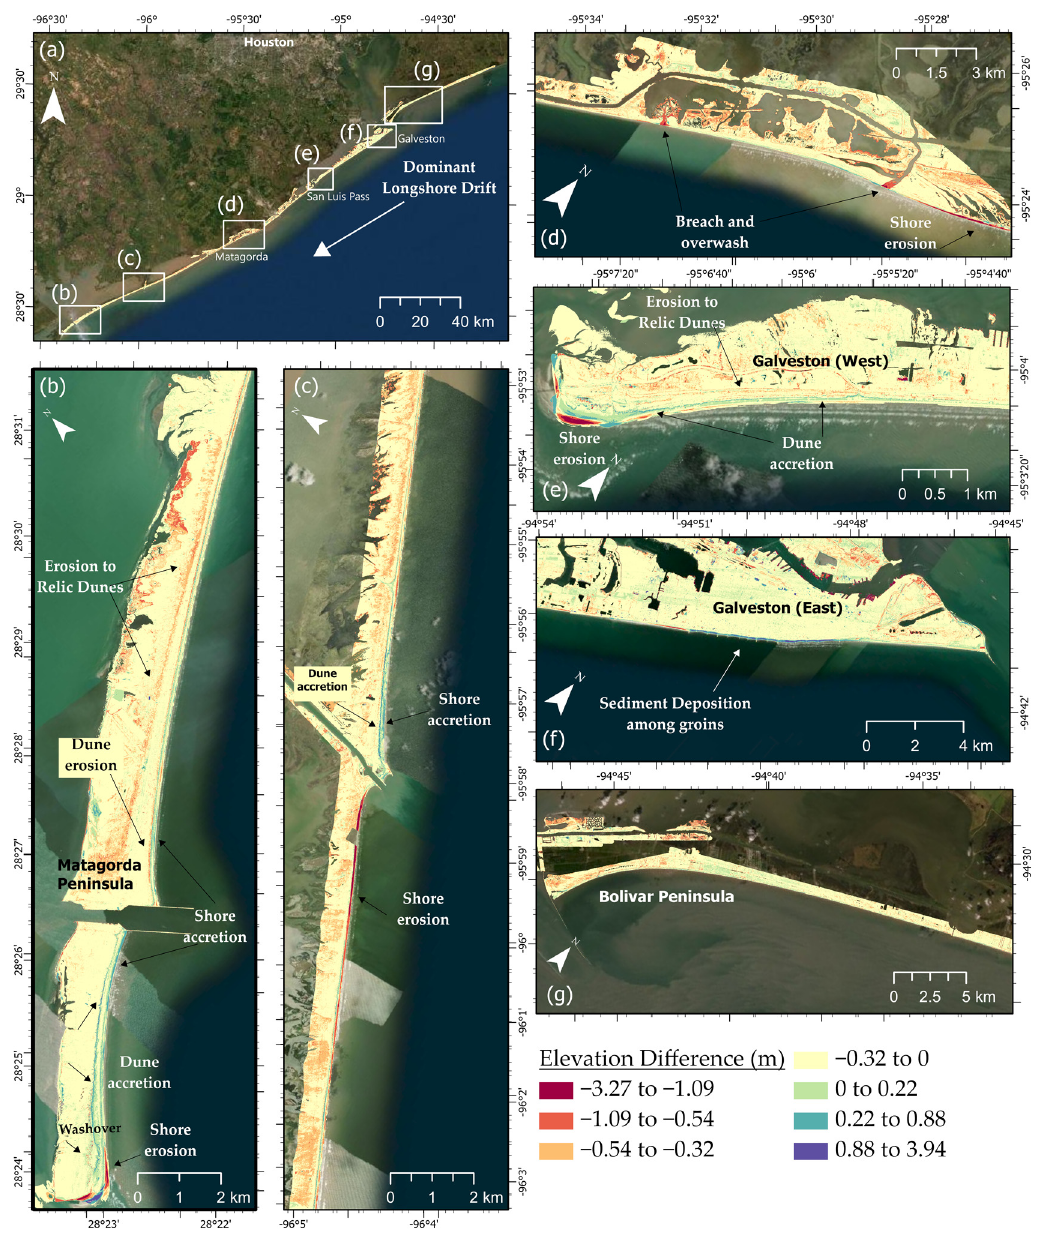
Figure 7. Digital elevation model difference map representing changes between 2016 and 2018. Erosion is represented by yellow, orange, and red. Sediment accretion is represented by green, turquoise, and purple. ( a ) For the full extent of regional data, refer to Figure 1b for the regional study extent in reference to the state of Texas; ( b ) Western end of Matagorda Peninsula; ( c ) Changes around Jetty Park and Matagorda Beach; ( d ) Overwash fans between Sargent and Freeport; ( e ) West end of Galveston Island; ( f ) East end of Galveston Island with seawall, jetty, and groins; ( g ) Bolivar Peninsula.